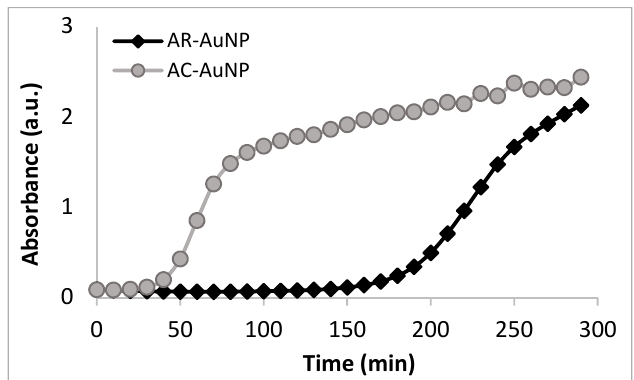
Figure 6. Change in absorbance with time during the syntheses of both the AC-AuNPs and AR-AuNPs at